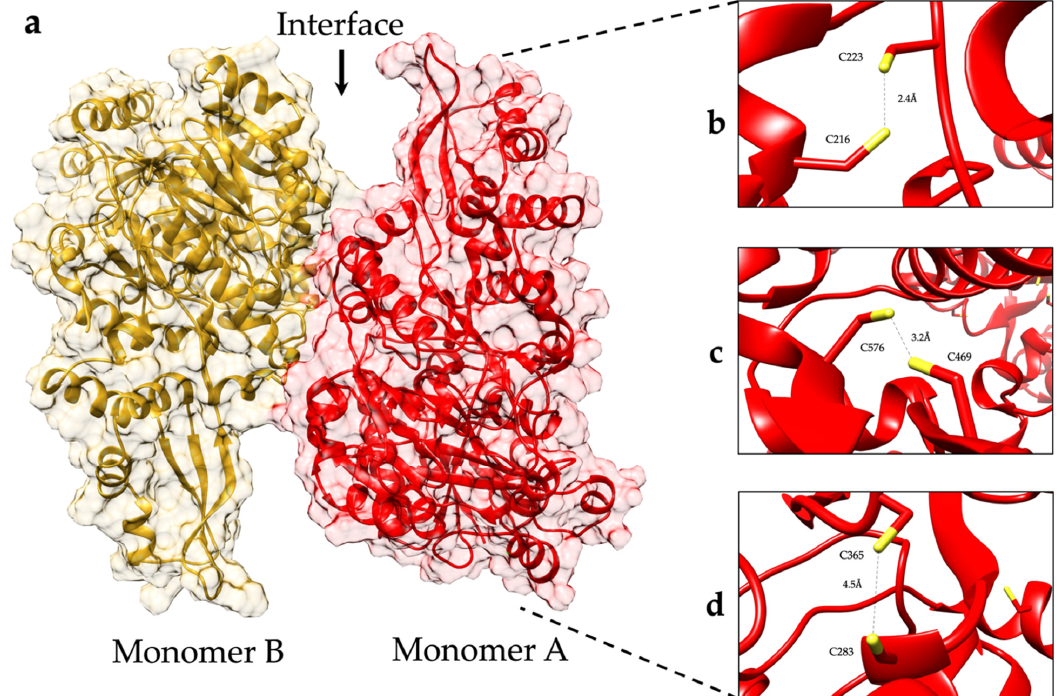
Figure 4. Ribbons and surface representation of the AlphaFold-predicted structure of GlADI. ( a ) The homo dimer with two identical subunits is the described biological active form of GlADI. ( b – d ) Based on the distance between their sulfur atoms, three pairs of cysteines might be forming disulfide bonds.